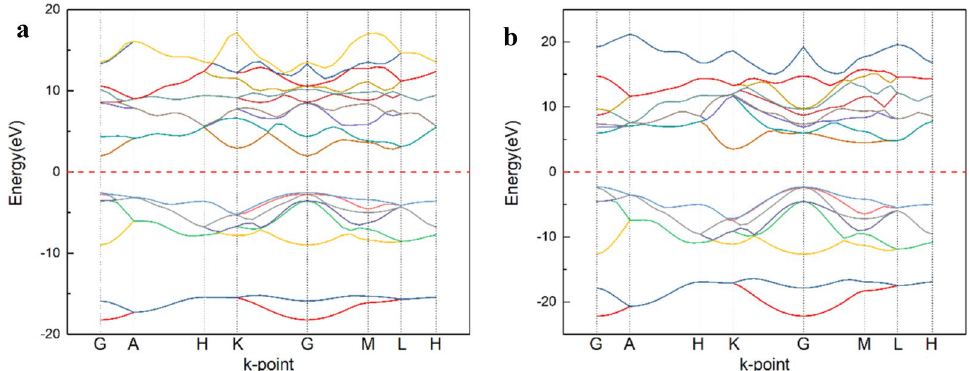
Figure 2. Band structure of ( a ) AlN, ( b ) BN crystal.